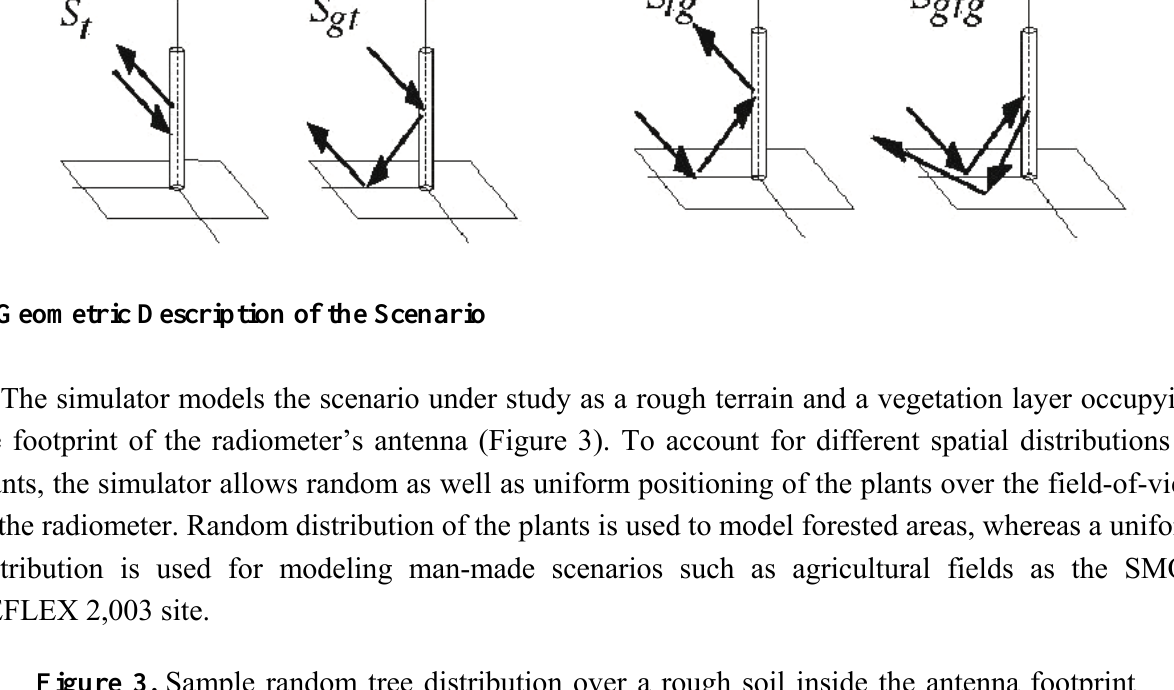
Figure 3. Sample random tree distribution over a rough soil inside the antenna footprint (leaves not